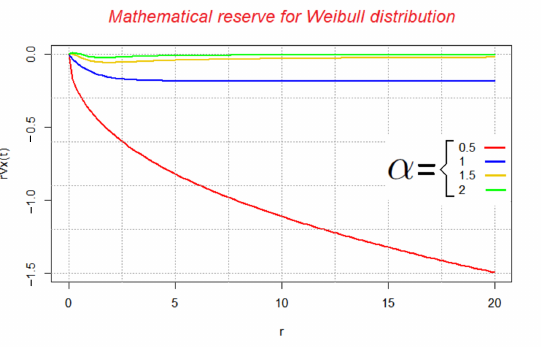
Figure 3. Mathematical reserve t ¯ V ( x ( 0 )) , for Weibull distribution with parameters θ = 1 and α = 0.5,1.0,1.5,2.0.